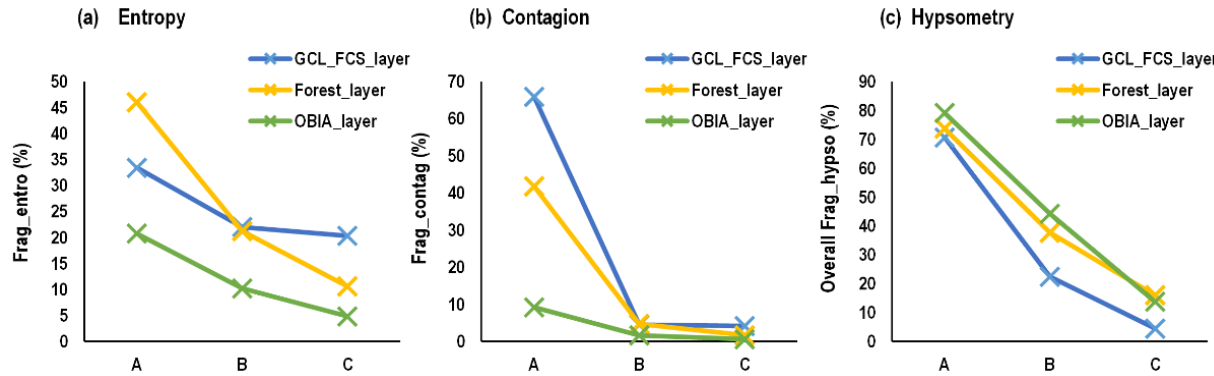
Figure 3. Describing the fragmentation level of maps with different spatial resolutions in different urban scenarios from the three indices: ( a ) Entropy, ( b ) Contagion, and ( c ) Hypsometry.